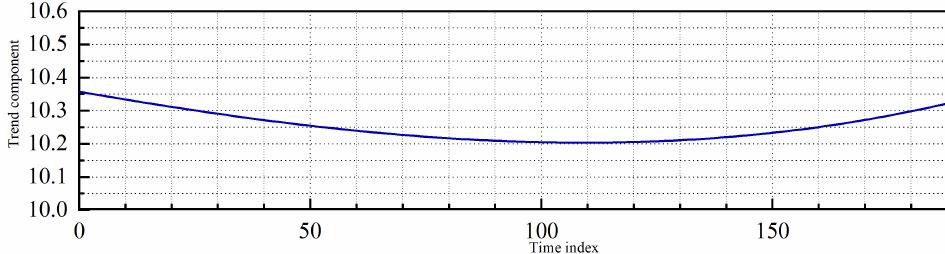
Figure 11. Trend